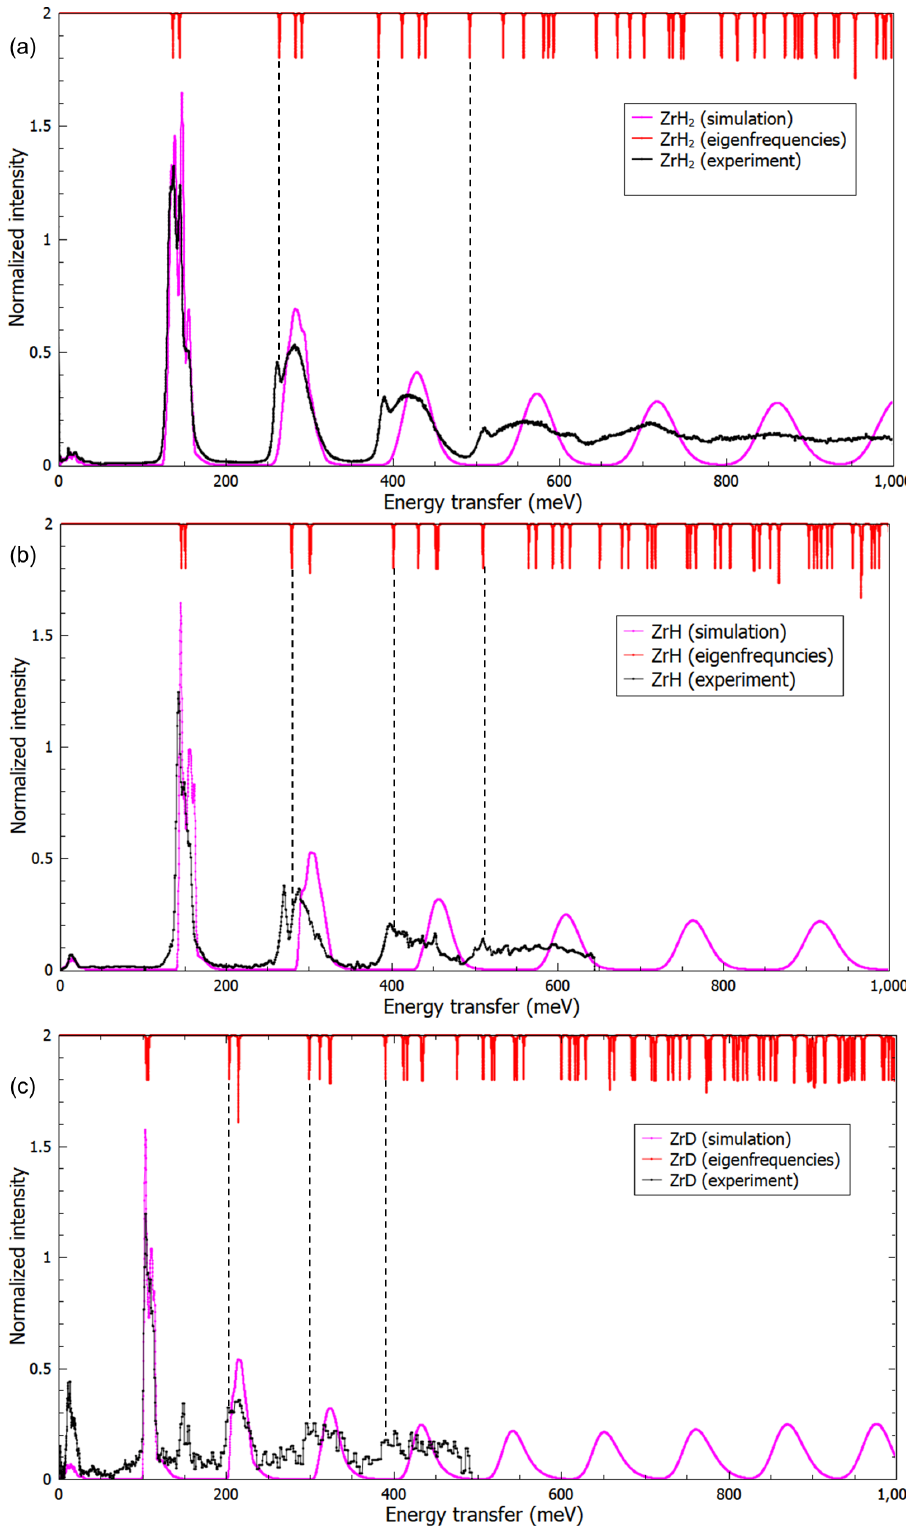
Figure 7. Comparisons between eigenfrequencies and experimental INS spectra for ( a ) (cid:101) -ZrH 2 , ( b ) γ - ZrH, and ( c ) γ -ZrD. Eigenfrequencies from the Schrödinger equation are in red lines, experimental INS spectra are in solid black lines, INS spectra simulated in harmonic approximation are in magenta lines, and the dashed black lines are for eye guidance of comparisons between eigenfrequencies and anharmonic peaks for the first three